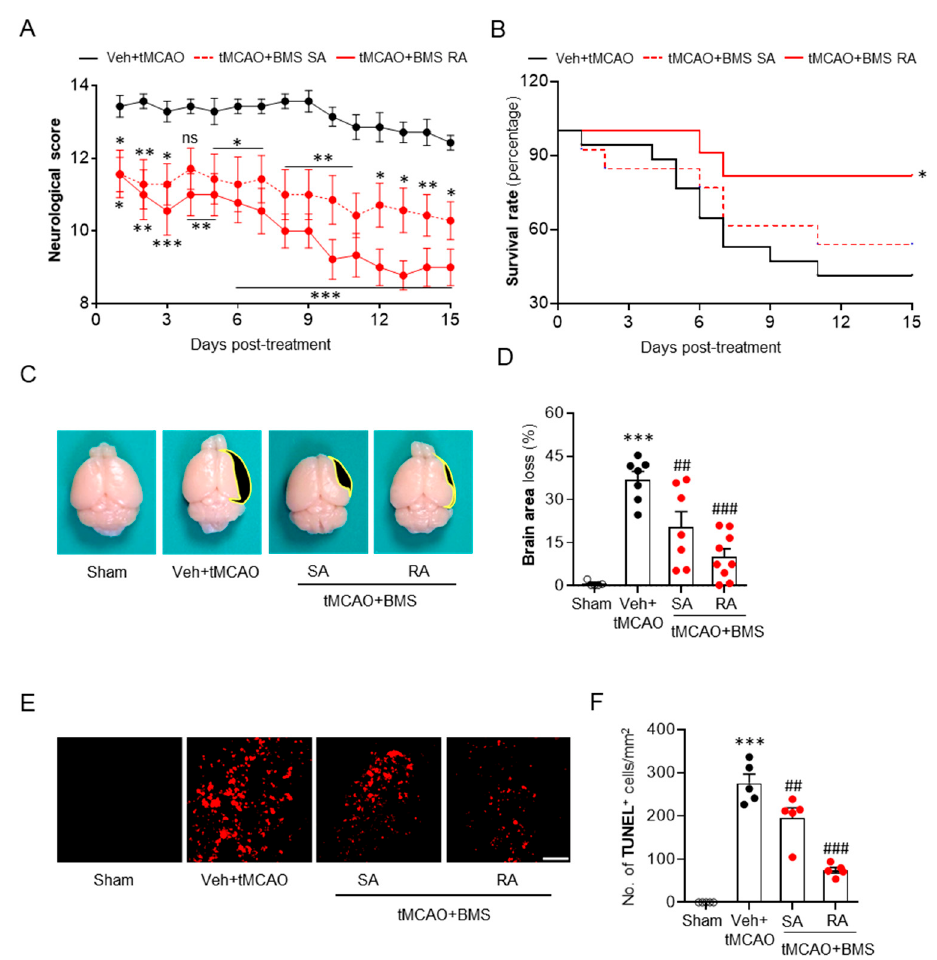
Figure 4. BMS administration reduces sub-acute brain injuries in mice for up to fifteen days after tMCAO challenge. Mice were challenged with tMCAO. BMS (5 mg / kg) was administered either once immediately after reperfusion (single administration of BMS, “SA”) or daily (repeated BMS administration, “RA”) for 14 days after tMCAO challenge. ( A , B ) Effects of BMS on neurological deficits ( A ) and survival ( B ) were determined for up to fifteen days after tMCAO challenge. n = 7 (Veh + tMCAO; black solid line), 7 (SA + tMCAO; red dotted line), and 9 (RA + tMCAO; red solid line). * p < 0.05, ** p < 0.01, and *** p < 0.001 versus vehicle-administered tMCAO mice (Veh + tMCAO). ns, not significant. ( C , D ) Effects of BMS on brain tissue loss were determined at day 15 after tMCAO. Representative brain images ( C ) and quantification ( D ) are shown. Black-colored areas in C indicate lost areas. n = 5 for sham, 7 for Veh + tMCAO, 7 for SA + tMCAO, and 9 for RA + tMCAO. *** p < 0.001 versus sham. ## p < 0.01 and ### p < 0.001 versus vehicle-administered tMCAO mice (Veh + tMCAO). ( E , F ) Effects of BMS on apoptotic cell death determined by TUNEL assay. Representative images of TUNEL-positive cells in the sub-ventricular zone (SVZ) ( E ) and quantification ( F ) are shown. Scale bar, 50 µ m. n = 5 mice per group. *** p < 0.001 versus sham. ## p < 0.01 and ### p < 0.001 versus vehicle-administered tMCAO mice (Veh + tMCAO).